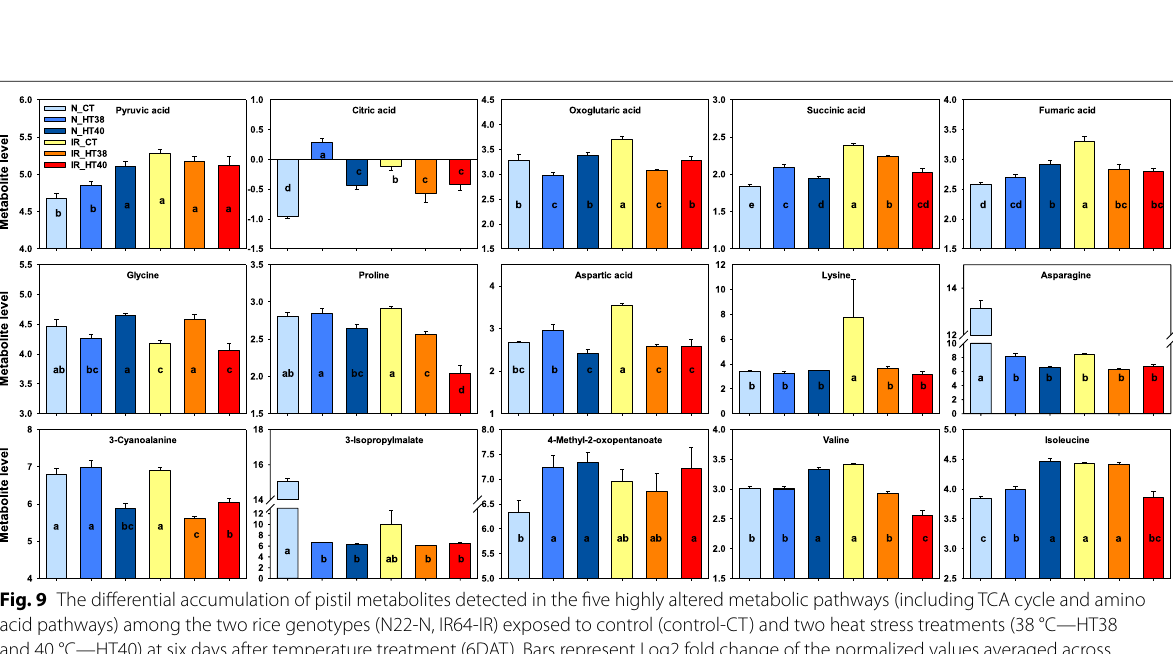
Fig. 8 A Principal components analysis (PCA) score plots of metabolite data to depict group divergence between cultivars and temperature treatments. B Hierarchical clustering through heat map illustrating the levels of metabolites under control and heat stress treatments (distance measure—Euclidean; clustering algorithm‑Ward). Values are means of six biological replicates. N, N22; IR, IR64; CT, exposure to temperature at 30 ℃ ; HT38, exposure to heat stress at 38 °C; HT40, exposure to heat stress at 40 °C. Green color with scale –2 represents lower accumulation of metabolite, whereas red color with scale 2 indicates higher accumulation of metabolite levels in each genotype and temperature treatment + combination